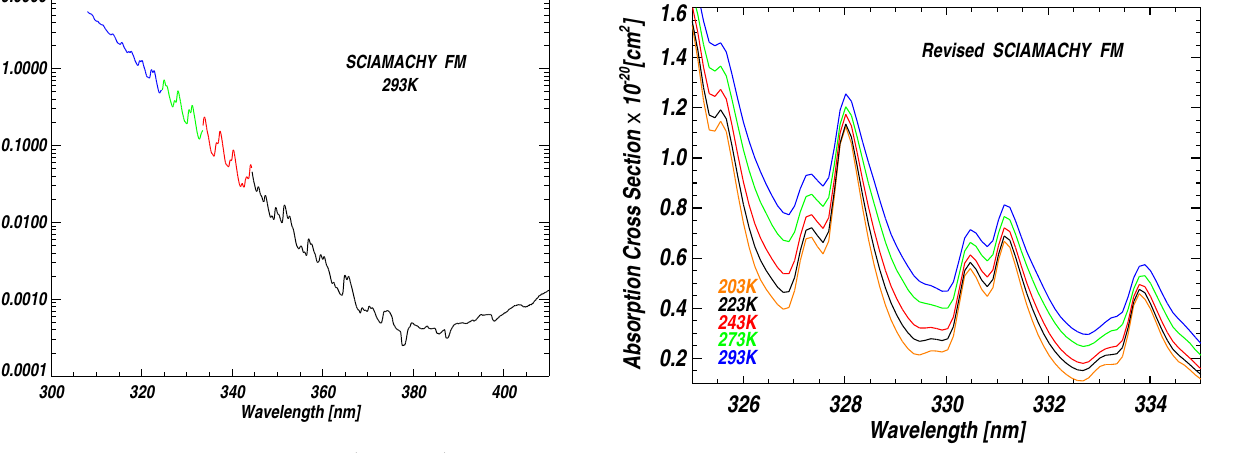
Fig. 5. Revised temperature-dependent SCIAMACHY FM ozone absorption cross-section spectra in the Huggins